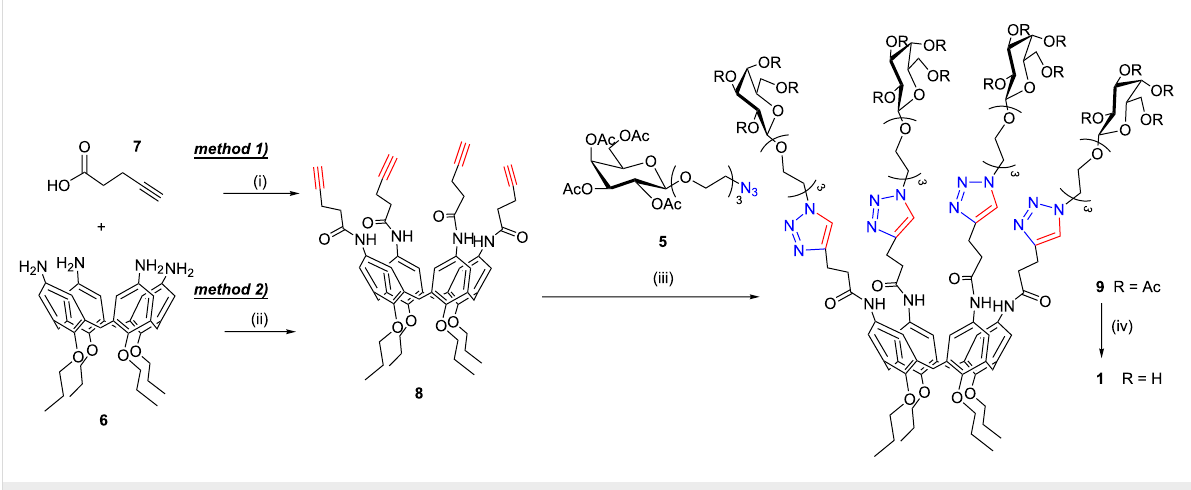
Scheme 1: Synthesis of the cone galactosylcalix[4]arenes 1 . Reaction conditions: (i) DCC, DMAP, CH 2 Cl 2 , under reflux, 5 h, 44%; (ii) EDC, CH 2 Cl 2 /py (7:3), rt, 18 h, 66%; (iii) CuSO 4 ·5H 2 O, Na-ascorbate, DMF/H 2 O, μ W (150 W), 80 °C, 20 min, 83%; (iv) CH 3 ONa, CH 3 OH, rt, 1 h – IR120/H + , rt, 30 min, quantitative.